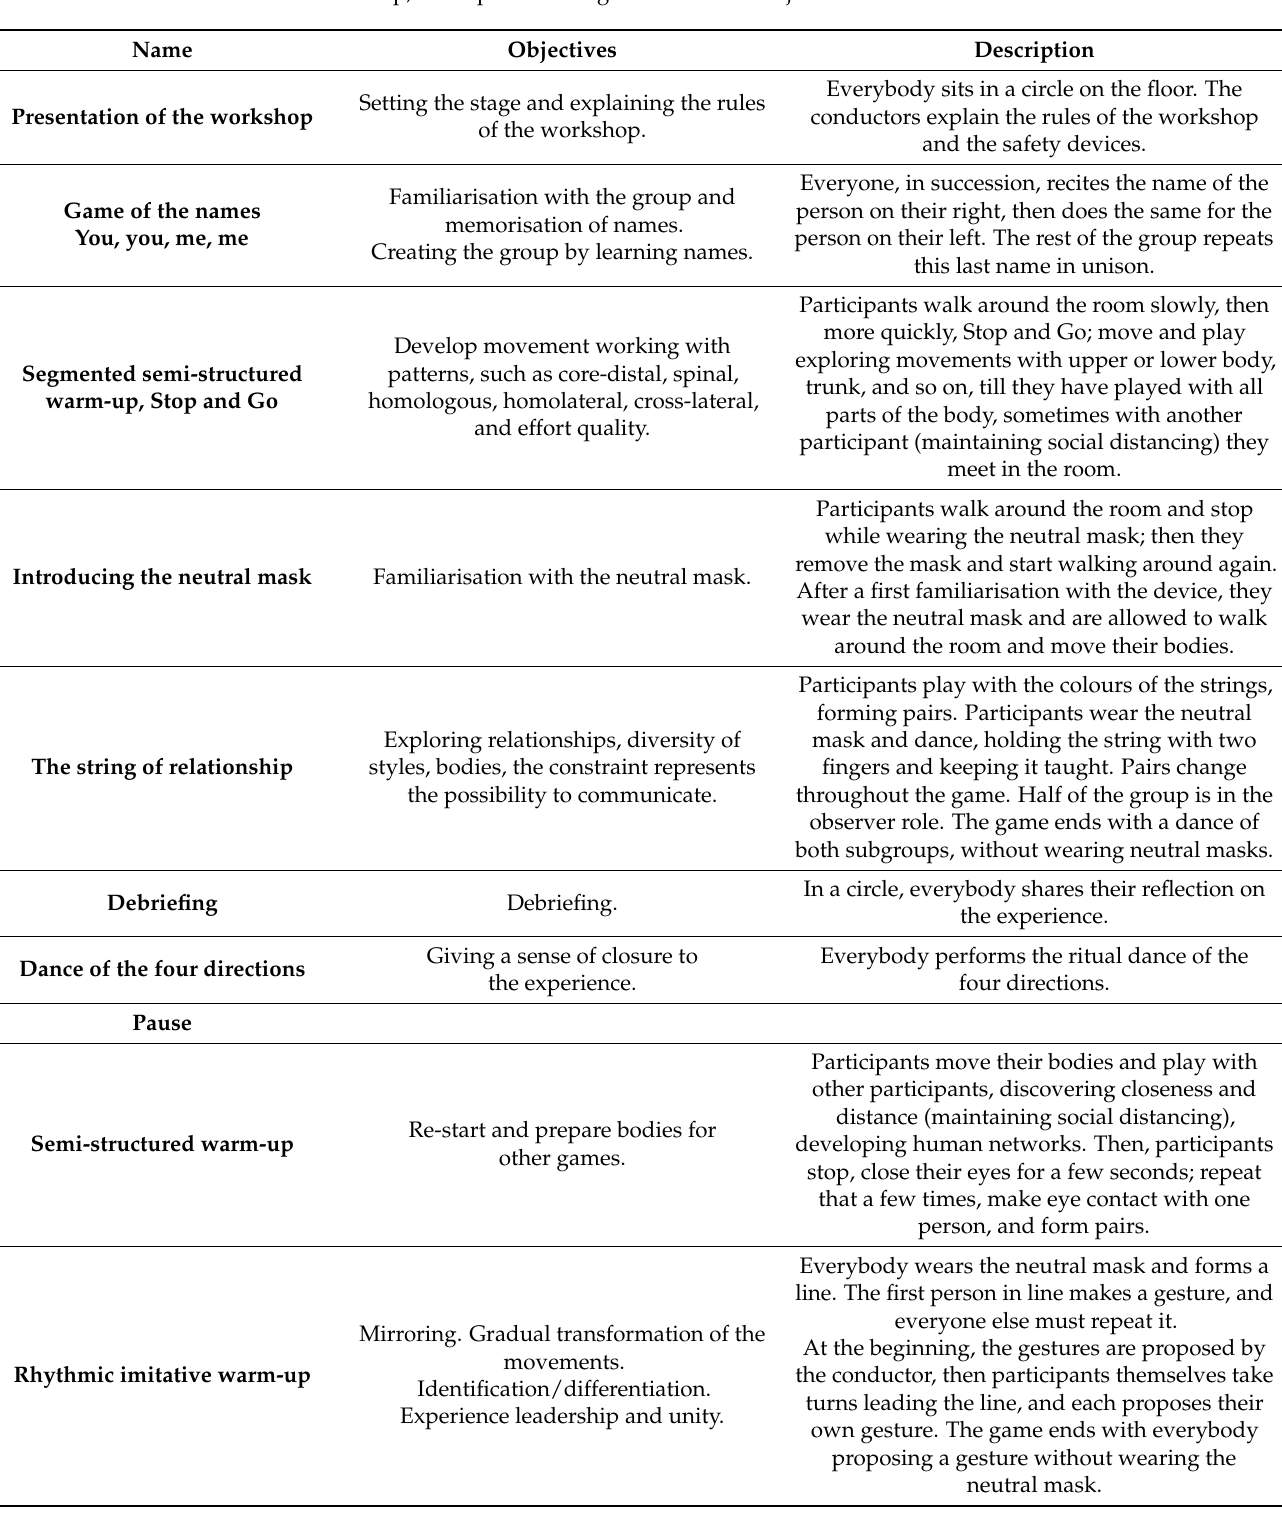
Table 1. Organisation of the Relational Expressive Dance Movement Therapy (DMT-ER) third-year workshop, description of the games and their